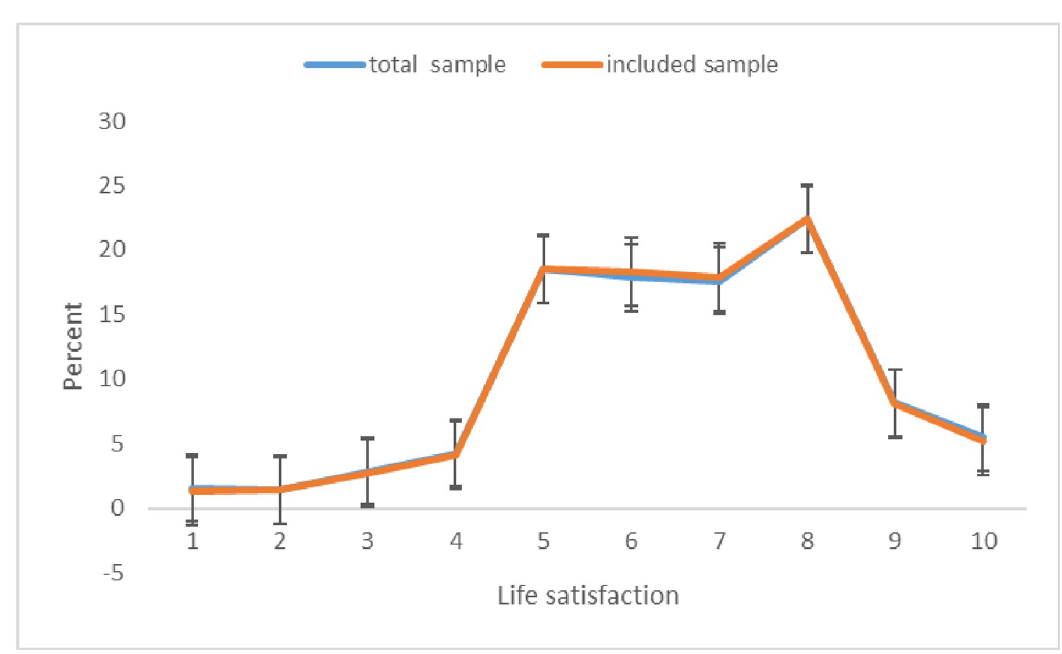
Fig 1. Comparison of the life satisfaction